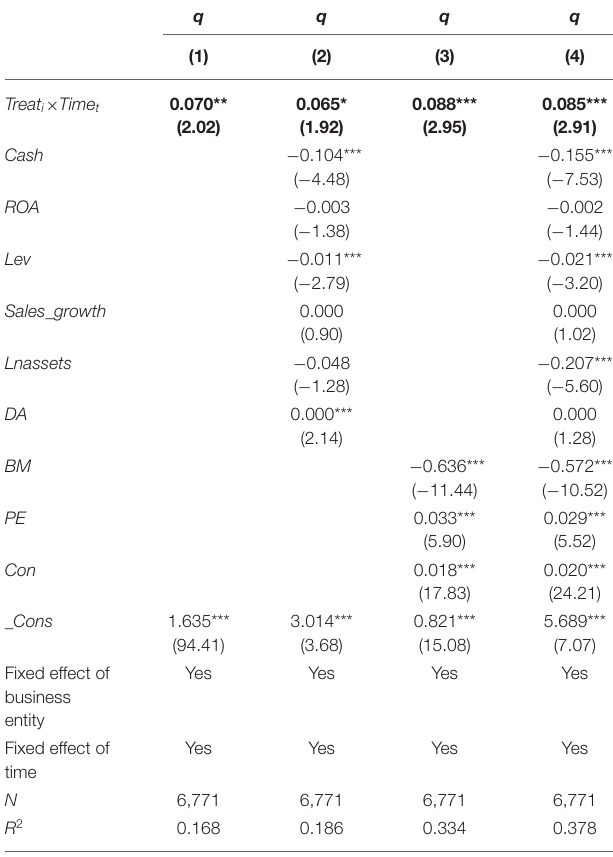
TABLE 2 | Results of benchmark